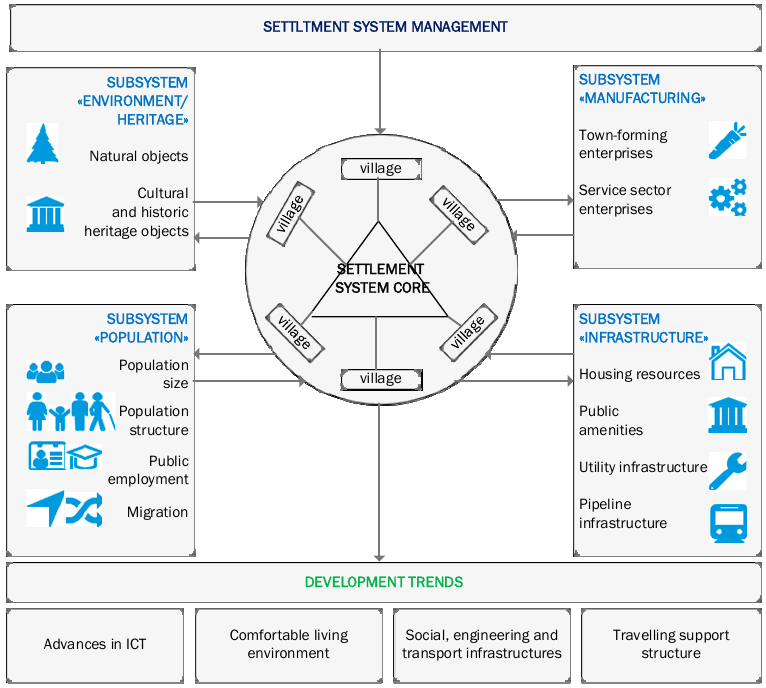
Figure 5. Conceptual Data Model for Rural Settlement System. Source: Own Work.